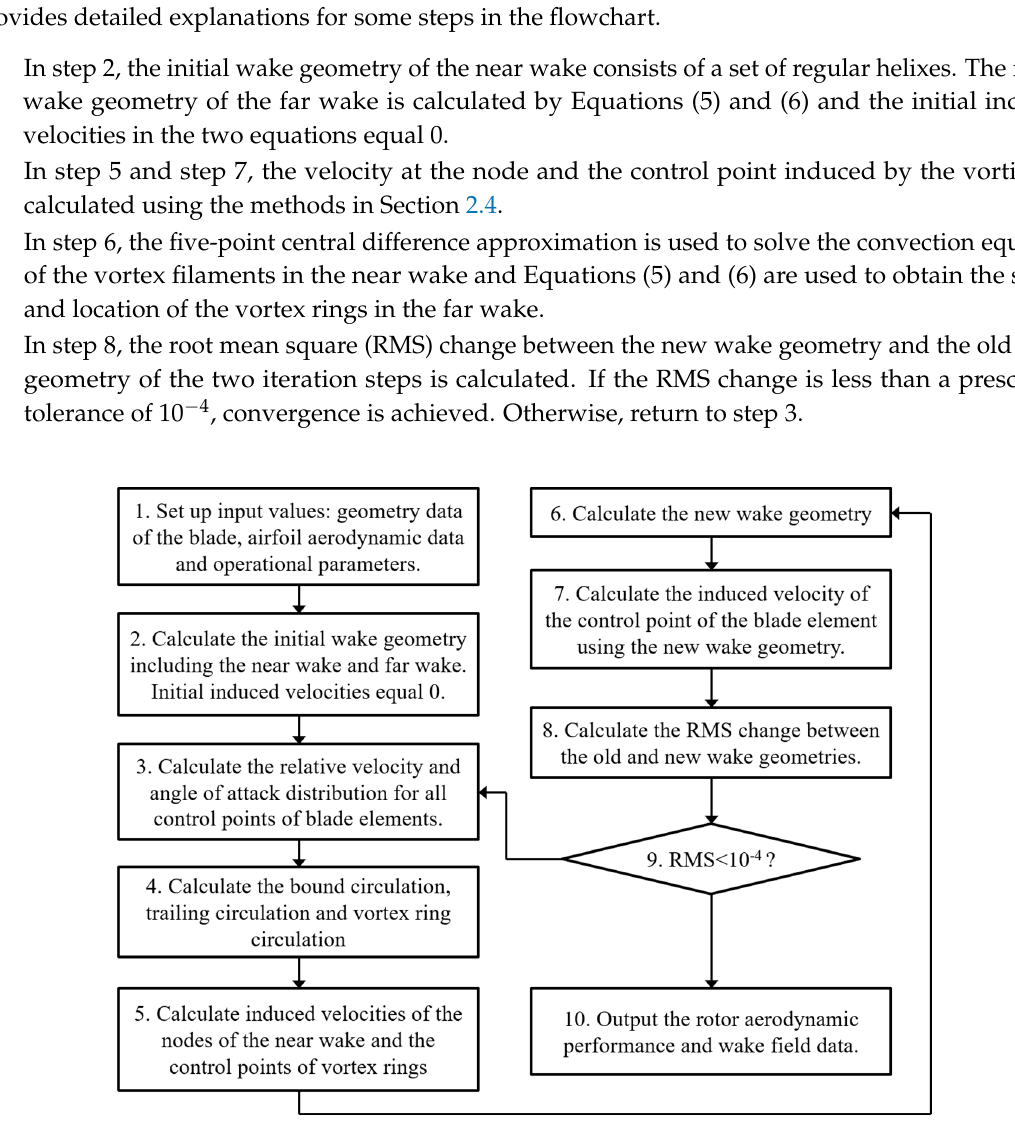
Figure 5. Schematic of the coordinate system for the induced velocity calculation of the vortex ring.